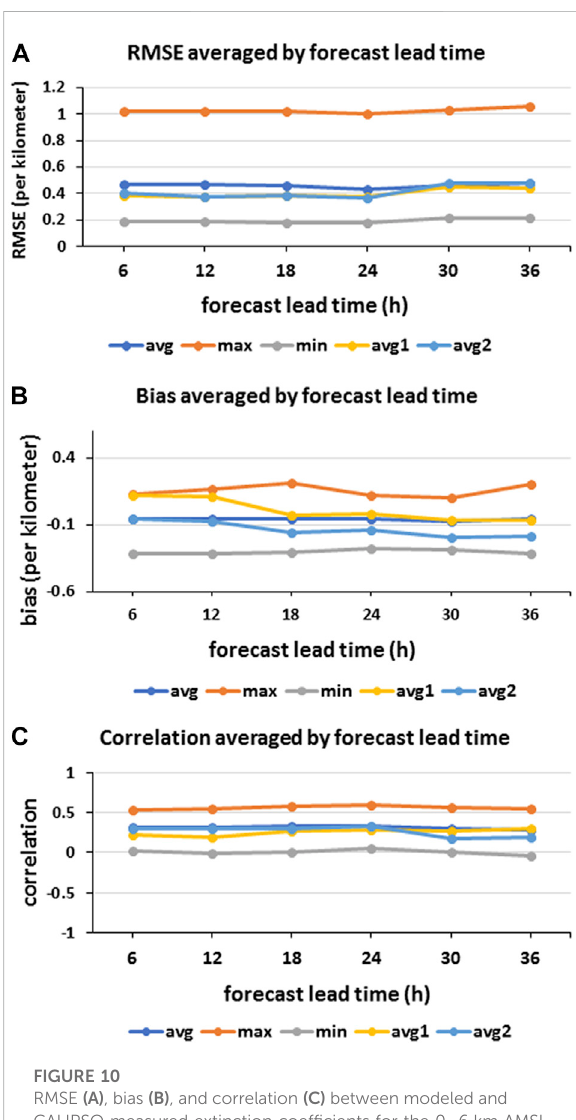
FIGURE 10 RMSE (A) , bias (B) , and correlation (C) between modeled